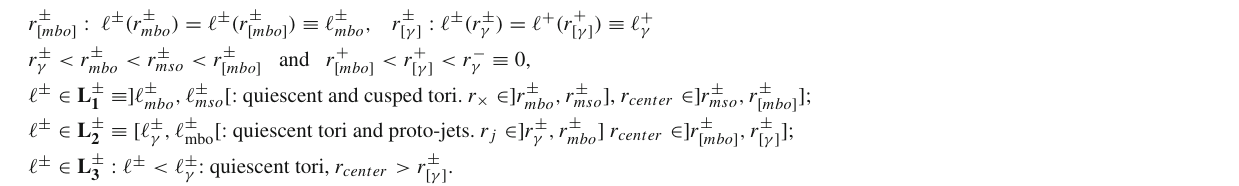
Fig. 1 Analysis of the extended geodetic structure of the Kerr NS , constraining tori with fluid angular momentum (cid:6) = (cid:6) ± . Spins { a , a , a , a , a , a , a , a , a } 0 1 2 4 6 7 8 9 5 are defined in Table 2. Radius r + γ is the counter – rotating last circular orbit relative to counter-rotating fluids with (cid:6) = (cid:6) + < 0, radius r + = 2 M , is (cid:11) the outer ergosurface on the } equatorial plane. { r ± mso , r ± mbo are the marginally stable orbit and marginally bounded orbits relative to fluids with (cid:6) ± respectively. Radii { r ± , r ± , r + } are defined [ mso ] [ γ ] [ mbo ] on Table 1. On radii r ± 0 ) = 0, and momenta are L ( r ± 0 there is E ( r ± δ ) = 0 Table 1 Co-rotating and counter-rotating tori in Kerr NSs . (cid:6) is the quantity q evaluated on a radius r • . Radii { r ± γ , r ±